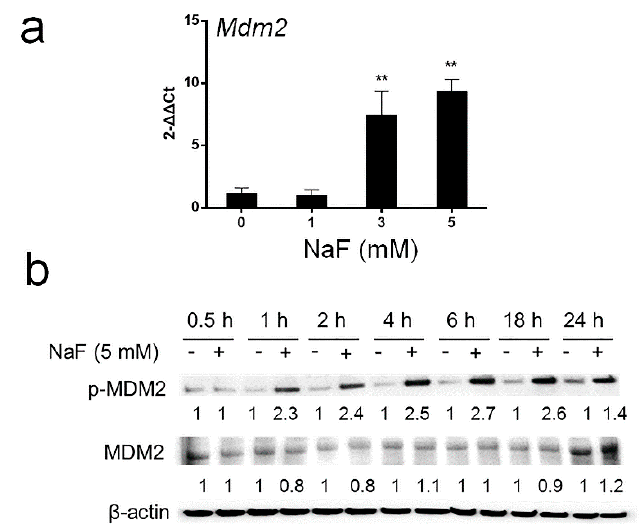
Figure 4. Fluoride induced Mdm2 mRNA expression and induced p-MDM2 protein levels in LS8 cells. ( a ) LS8 cells were treated with the indicated concentrations of NaF for 24 h and Mdm2 mRNA was quantified by qPCR. Fluoride (3 mM or 5 mM) significantly increased Mdm2 expression. Gapdh was the internal reference control gene. Data are presented as the mean ± SD (** p < 0.01 vs. 0 mM). ( b ) Cells were treated with NaF (5 mM) for the indicated times. Whole cell lysates were subjected